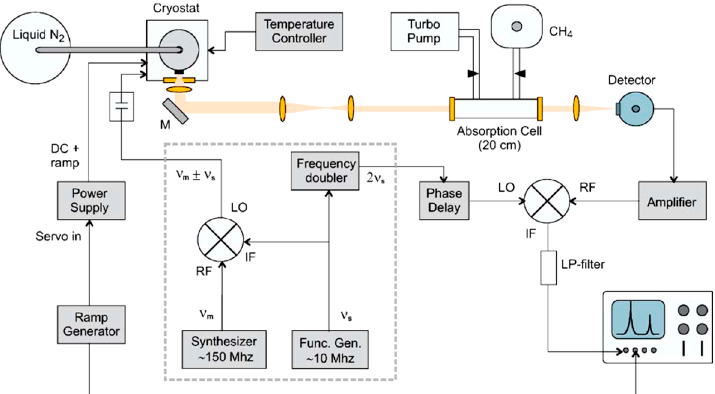
Figure 4. Schematic of the experimental set-up based on the FM technique. Reproduced with permission from [65], Springer, 2006.